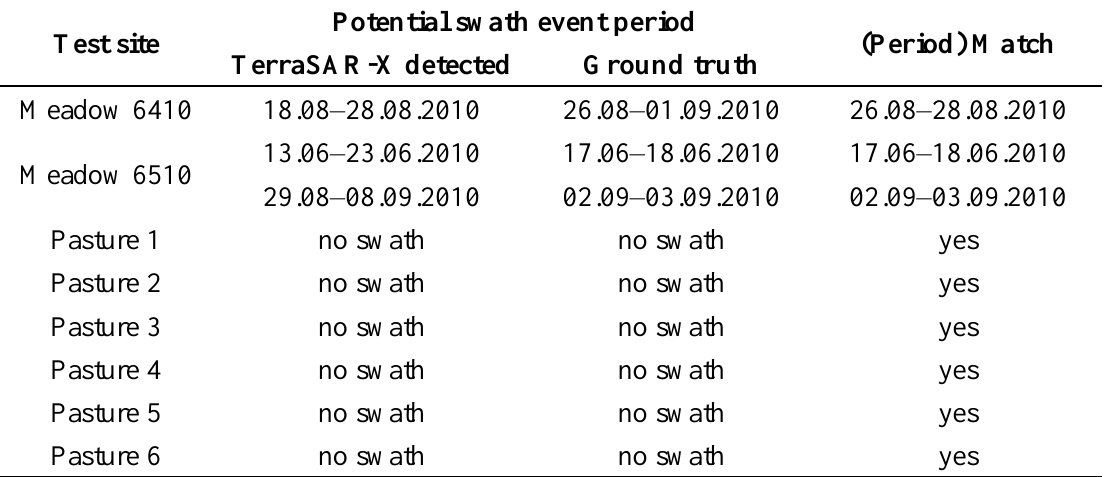
Table 2. Comparison of the potential swath event periods derived from TerraSAR-X or ground truth data respectively. Based on the period match, all three detected swath events are